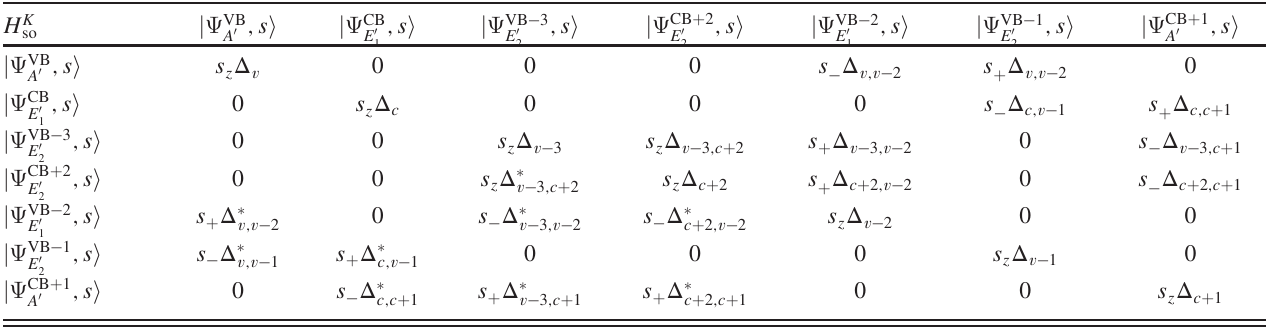
TABLE IV. SOC matrix of TMDCs at the K point in the seven-band model. H K